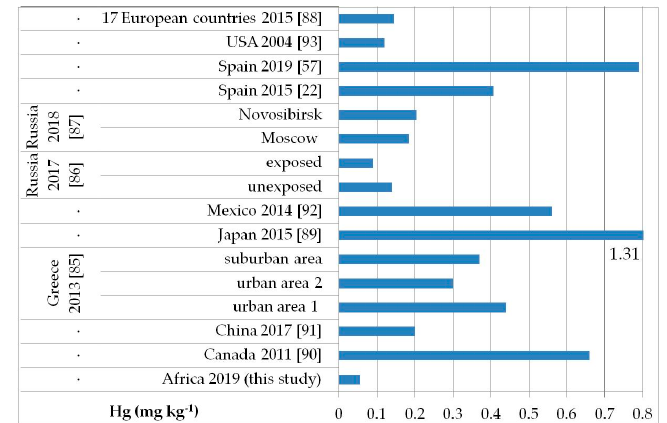
Figure 3. Comparison of the Cd concentrations in children’s hair (as geometric mean; mg kg − 1 ) found in our study and other biomonitoring studies.